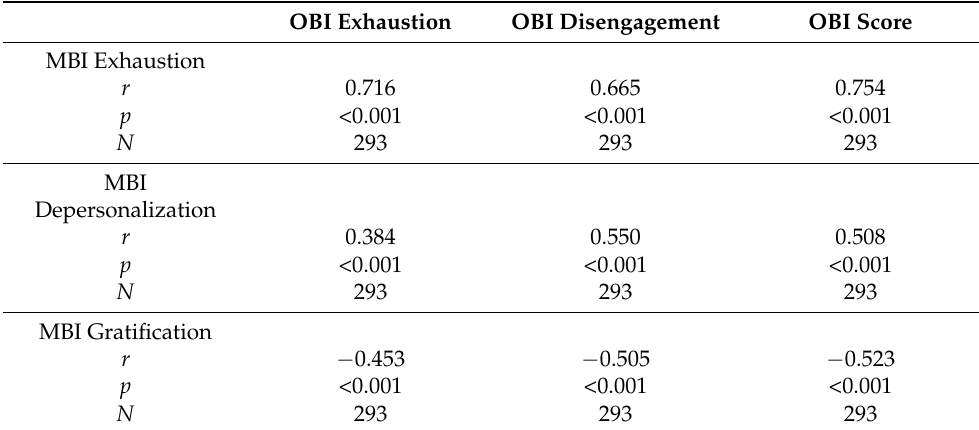
Table 4. Pearson’s correlation of the OBI scores and the MBI